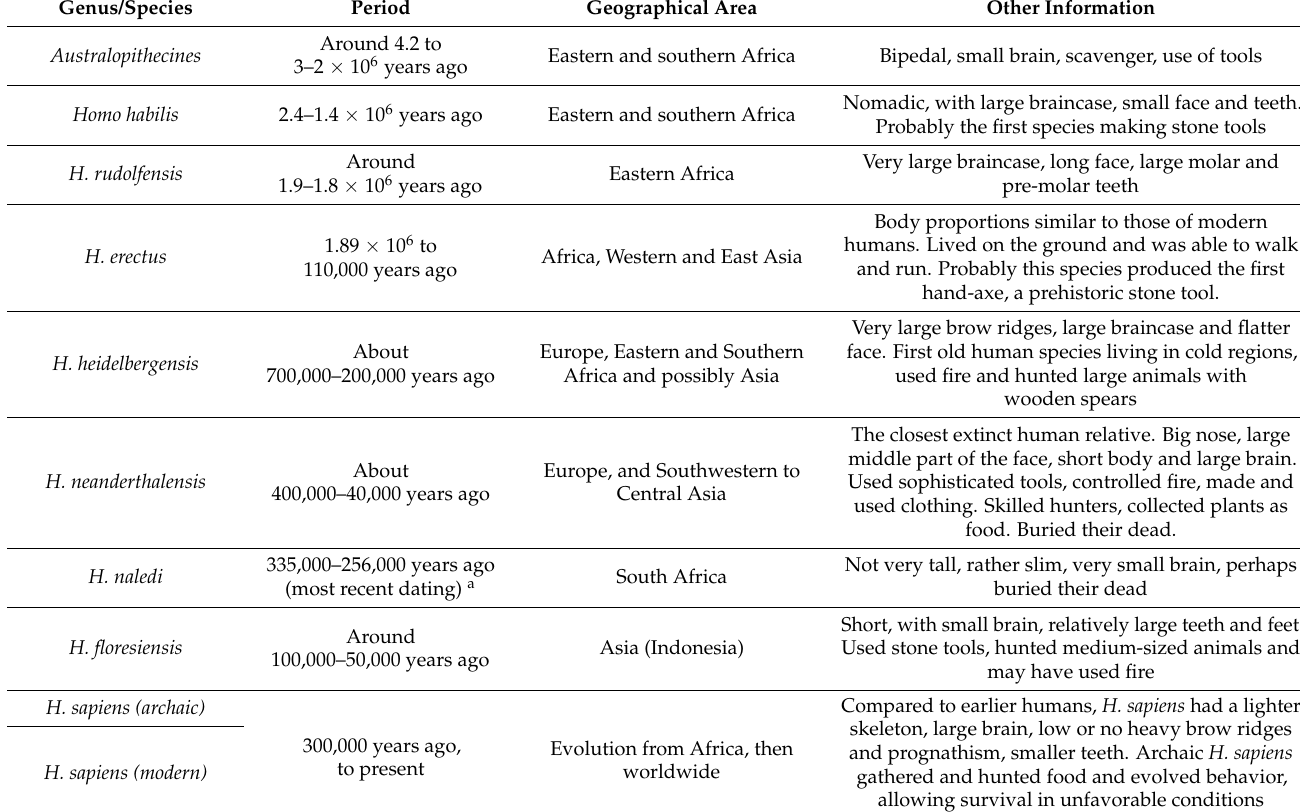
Table 1. Human evolution and related characteristics